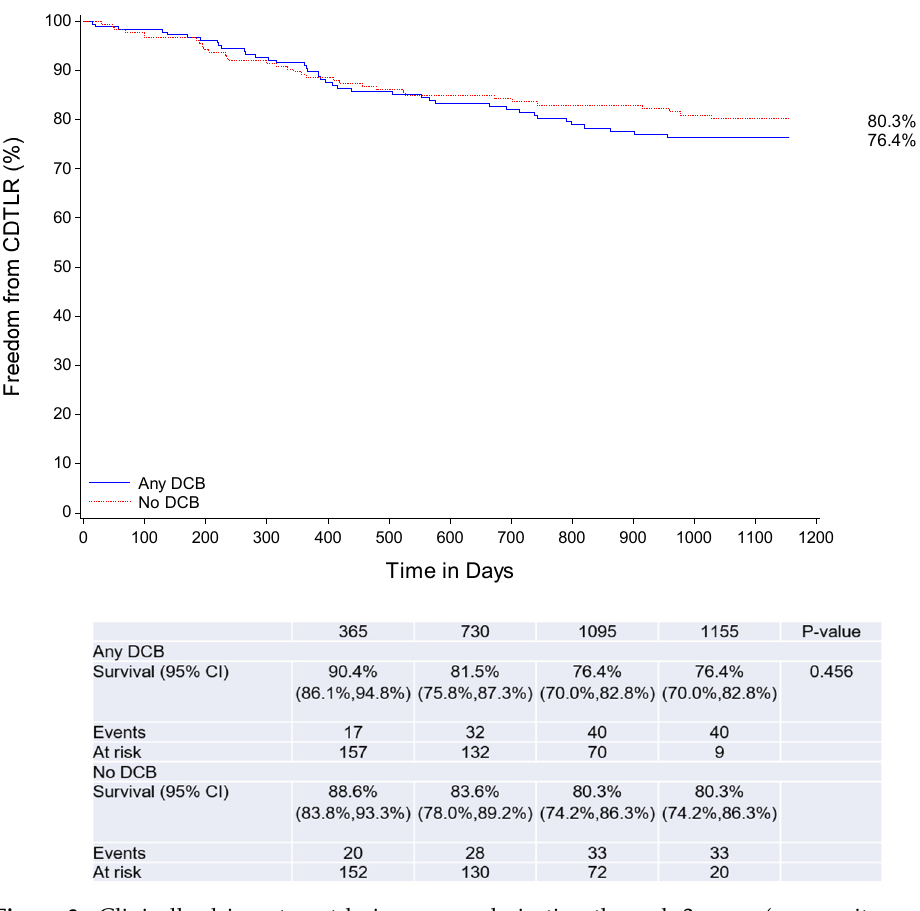
Figure 3. Clinically driven target lesion revascularisation through 3 years (propensity-matched cohorts). CD-TLR—clinically driven target lesion revascularisation, DCB—drug-coated balloon.